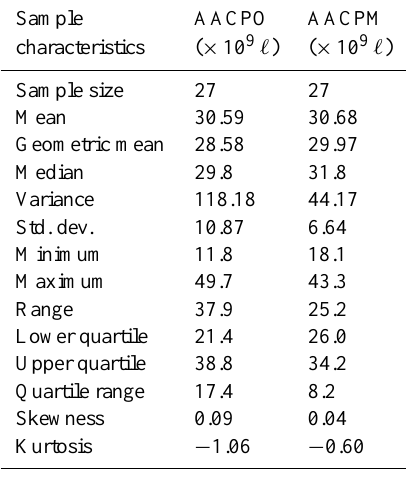
Fig. 4. Scatter diagram of model areal accumulated convective pre- cipitation (AACPM) values (10 9 ‘ ) vs. their observed counterparts (AACPO) for the treated study area. The solid line is the 1:1 corre- spondence between model and observed values. The linear regres- sion is presented with the dash line and the equation at upper part of the figure. Sample size ( n ), correlation coefficient ( r ) and bias are also shown.